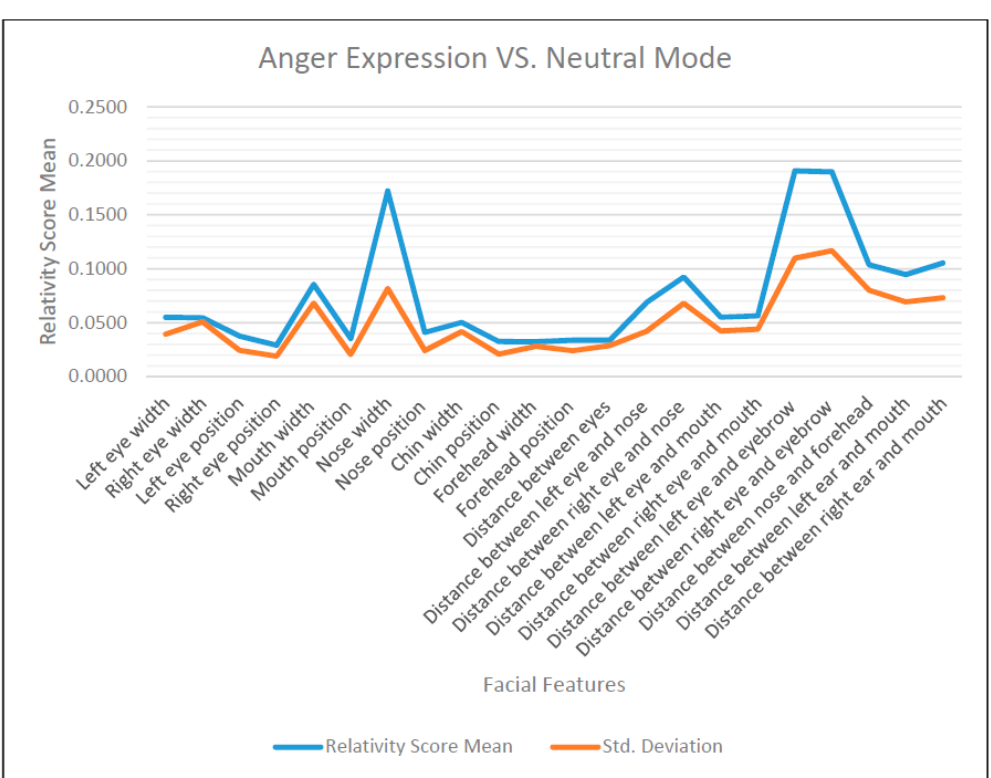
Figure 17. The means of RSS between anger expression and neutral mode of facial features for 36